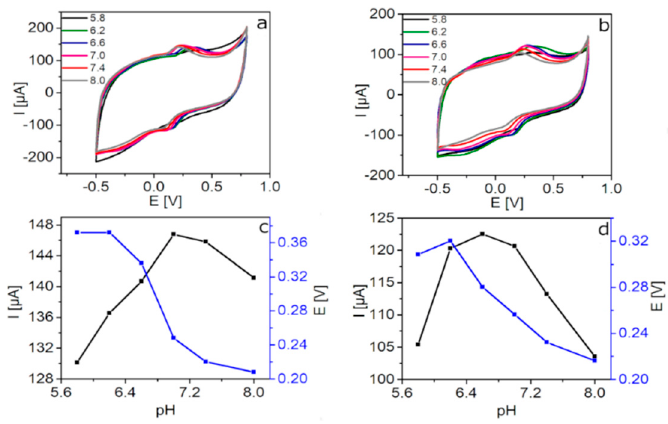
Figure 3. CVs recorded on ( a ) GCE/rGO-Au and ( b ) GCE/N-rGO-Au electrodes at different pH values in 0.1 M PBS containing 100 µM DA. Effect of the pH on the anodic peak current and anodic peak potential value of the oxidation of DA for ( c ) GCE/rGO-Au and ( d ) GCE/N-rGO-Au.